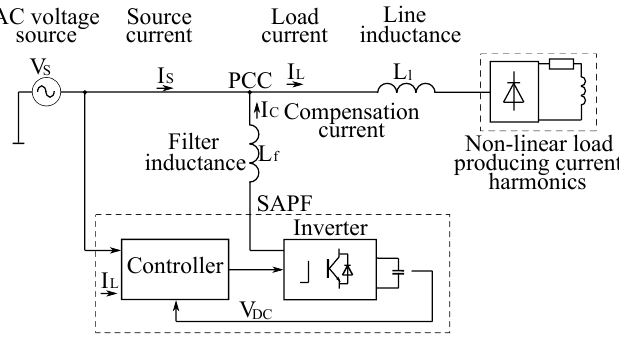
Figure 1. Block diagram of a shunt active power filter (SAPF).